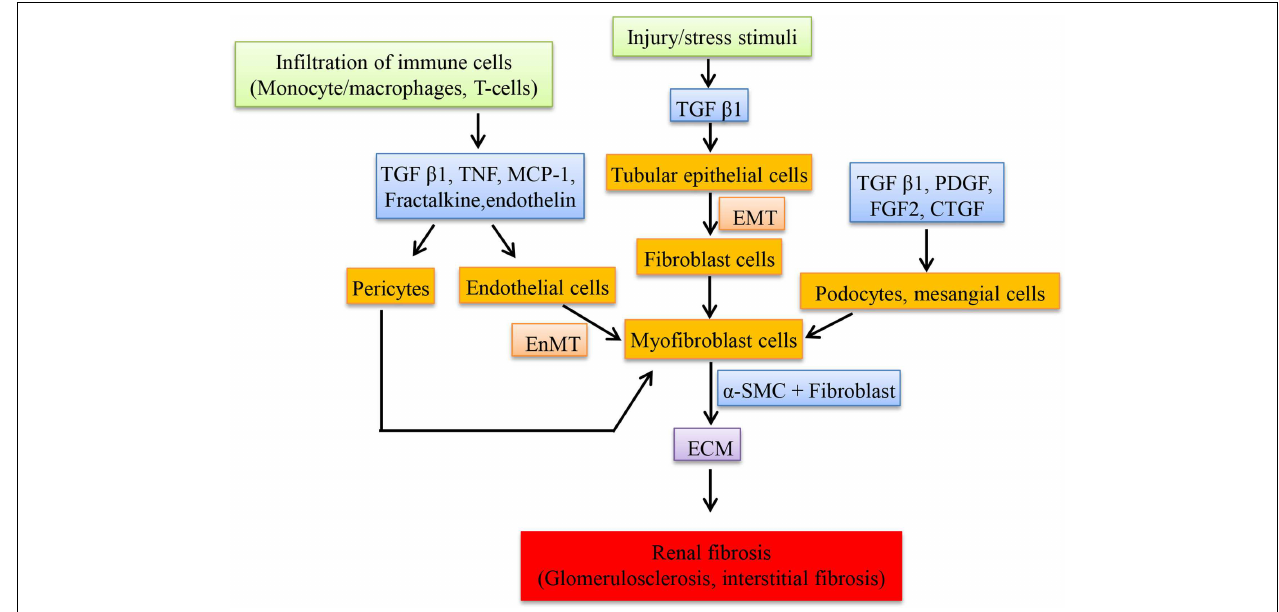
FIGURE 2 | Schematic representation of cellular mediators involved in renal fibrosis . The infiltration of macrophages secretes a set of mediators at the injured sites of kidney resulting in the transition of resident cells to myofibroblast cells, which proliferate and secrete the extracellular matrix compounds.